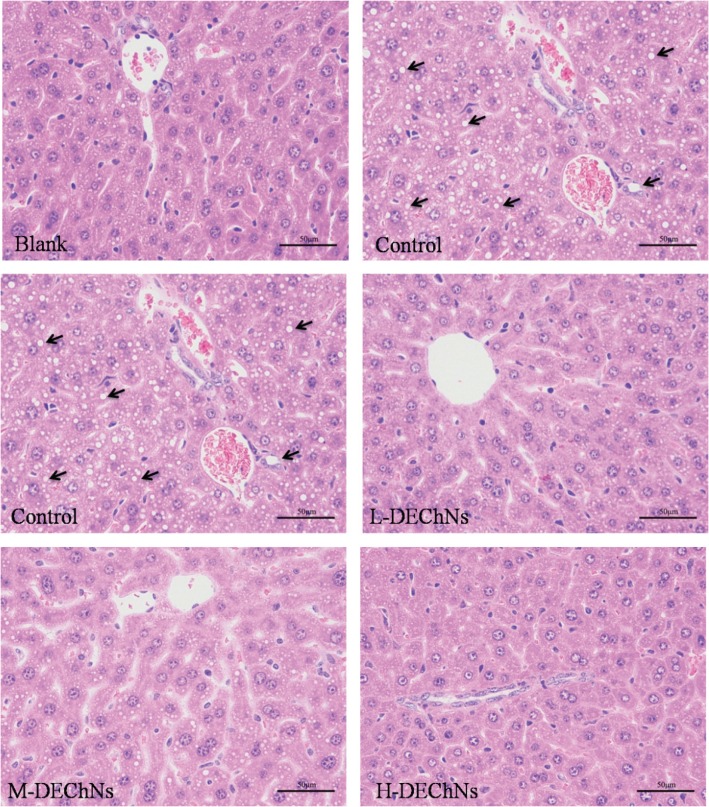
Histological examination of liver tissues from mice in the blank group (fed a normal diet and saline solution), control group (fed a high-fat diet and dilute acetic acid solution), and the L-, M-, H-DEChN groups (fed a high-fat diet and low, medium, high doses of DEChN dispersions, respectively). The arrows point out the fat vacuole in the cytoplasm.